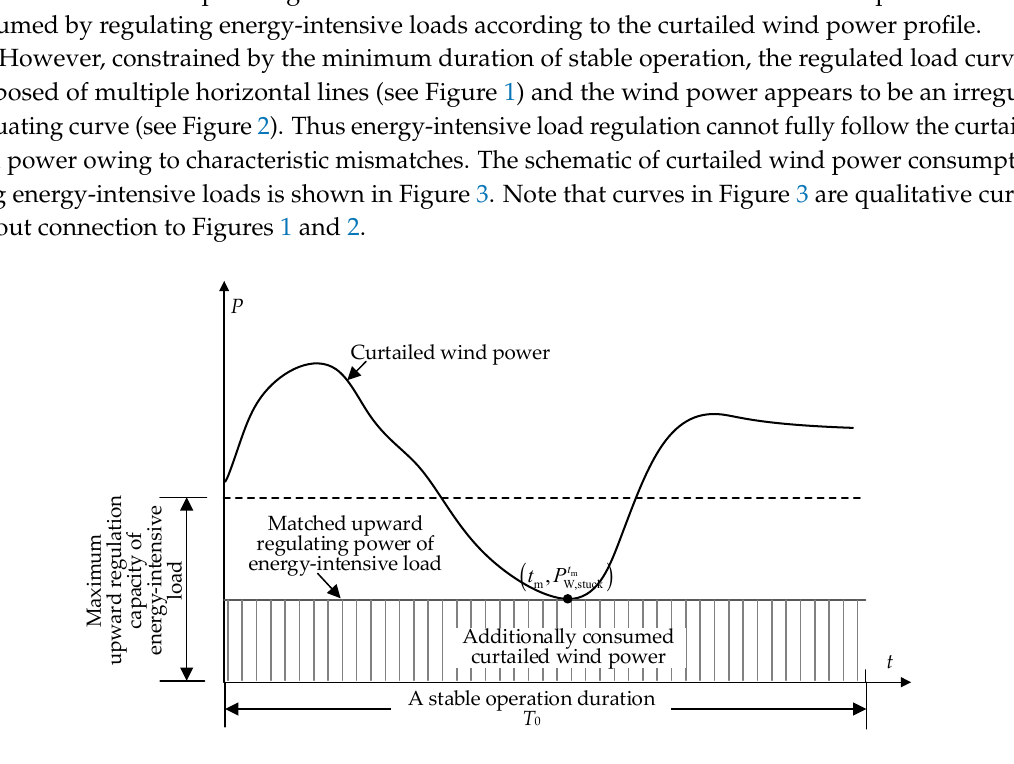
Figure 2. Profile of wind power in Hexi, Gansu.